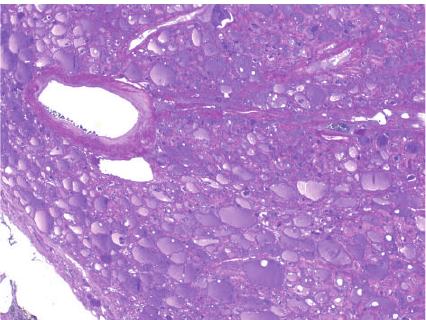
Figure 3: Pink-colored substance accumulation compatible with amyloidosis is seen in the arterial wall inside the nodule together with the parafollicular area and interstitium (crystal violet).